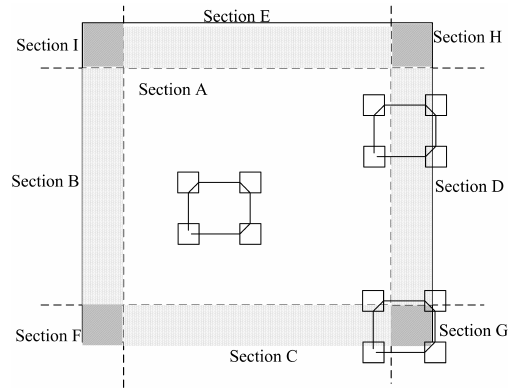
Figure 11. Digram of loop-back area sections.